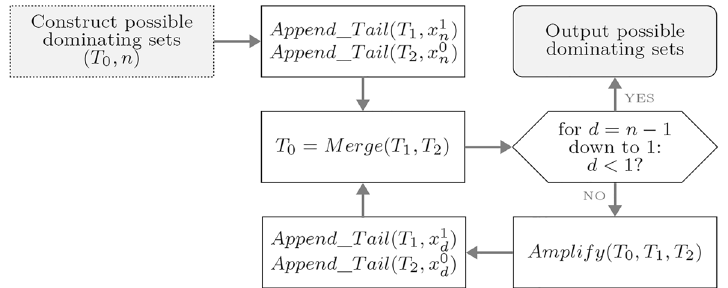
Figure 3. Biomolecular procedure for constructing the dominating set candidate